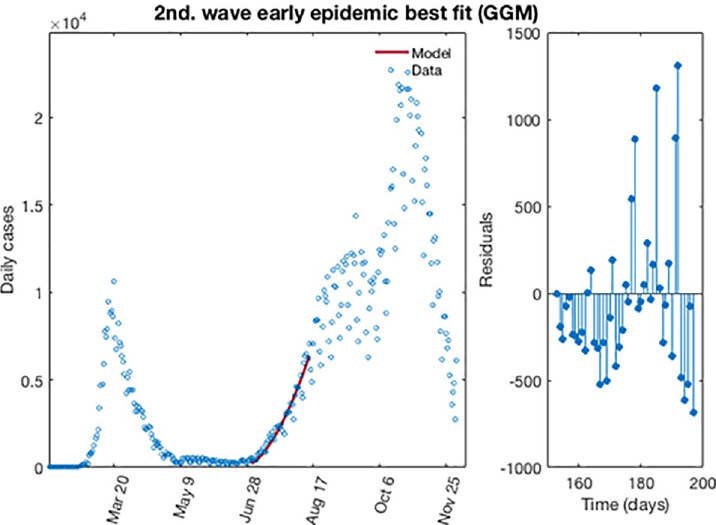
Fig 9. The best fit for GGM of the early epidemic period for the second wave for COVID-19 in Spain. Blue circles represent the reported daily case incidence, while continuous red line corresponds to the best fit of the model. The residuals are displayed in the right